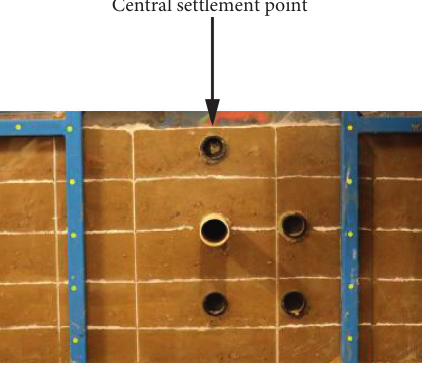
Figure 7: Central settlement